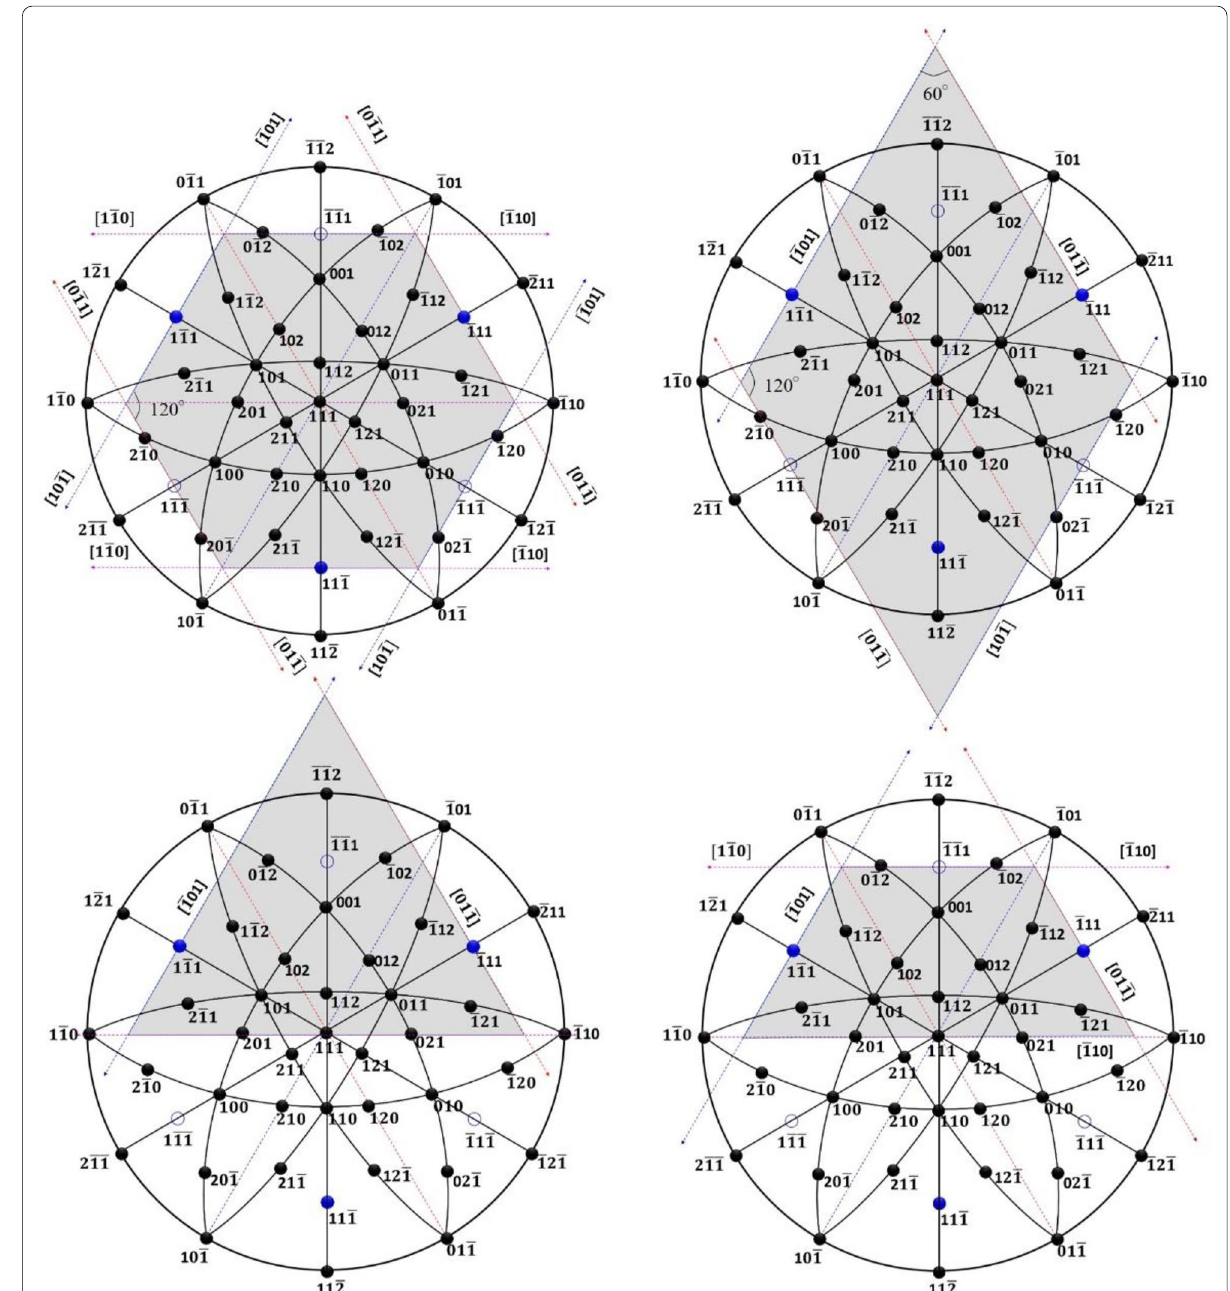
Fig. 2 Different shapes formed by < 110 > crystallographic directions at which {111} planes appear during wet anisotropic etching process such as hexagonal, rhombus, triangle, isosceles